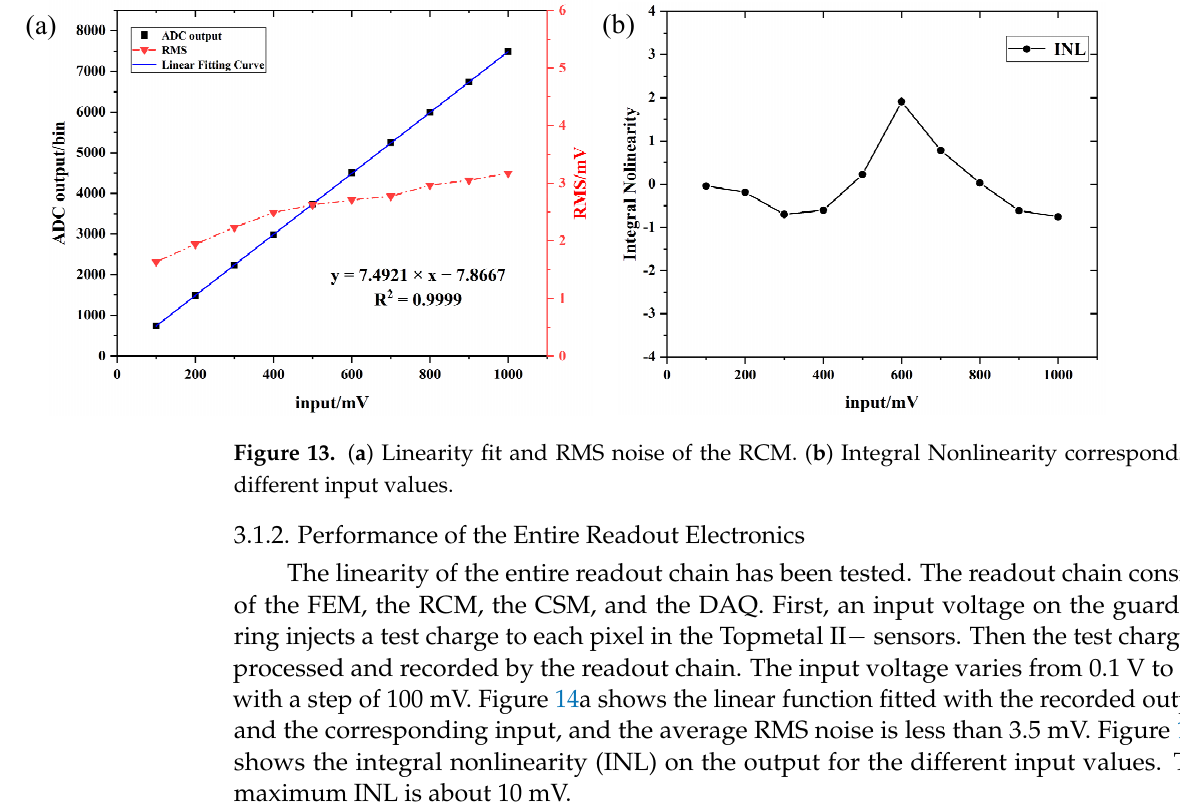
9 of 13 Figure 12. Simulation of distribution of secondary radiation dose rate in CEE. 3. Performance Measurement To evaluate the function and performance of the readout electronics, we have con- ducted a series of tests. 3.1. Characterization of the Readout Electronics in the Lab 3.1.1. Linearity of the RCM A test platform was built in the lab to evaluate the RCM’s linearity. In the test, a